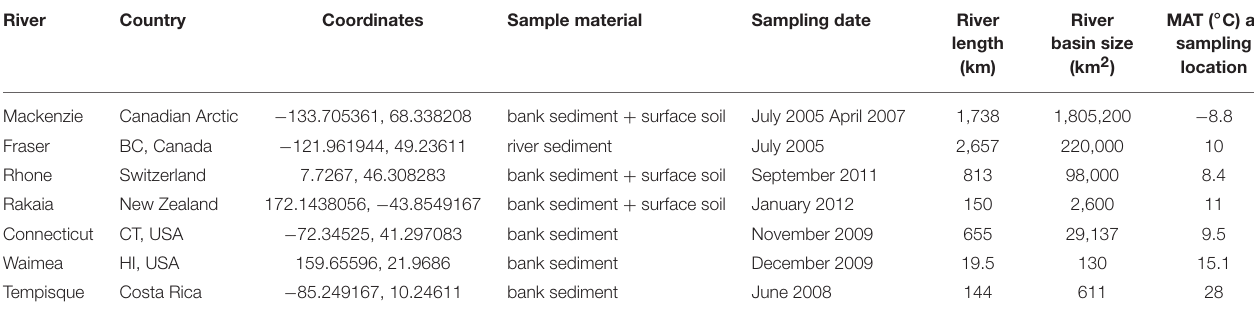
TABLE 1 | Coordinates and sample information of riverbank sediments and soils used in this